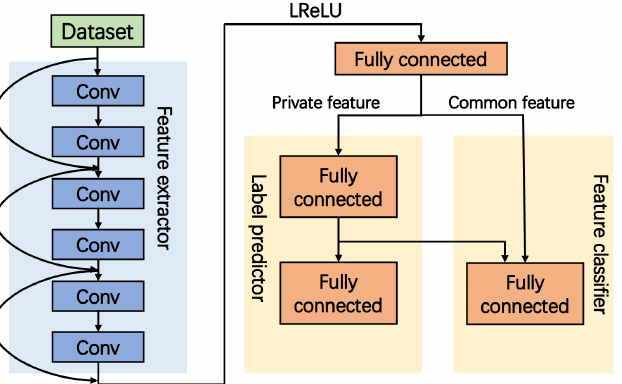
Figure 15. The structure of the proposed feature separation